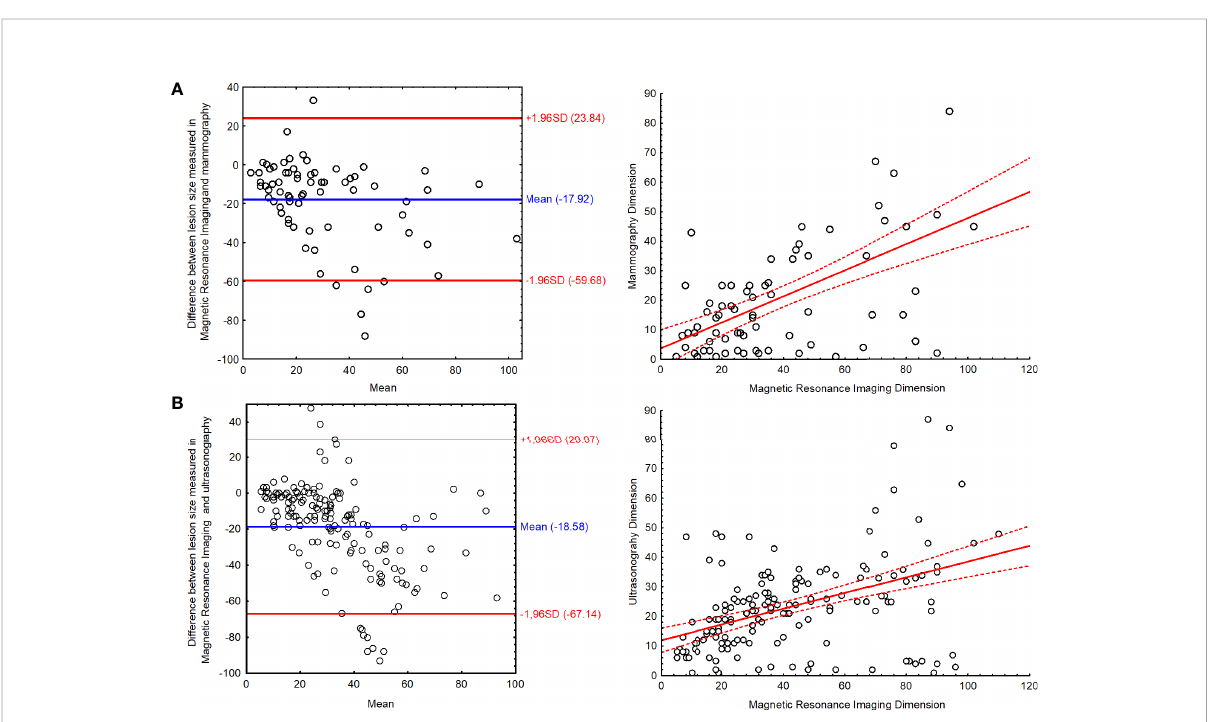
FIGURE 4 The Bland – Altman plot with scatter plot for the results of lesion size measured in magnetic resonance imaging and (A) mammography and (B) ultrasonography.